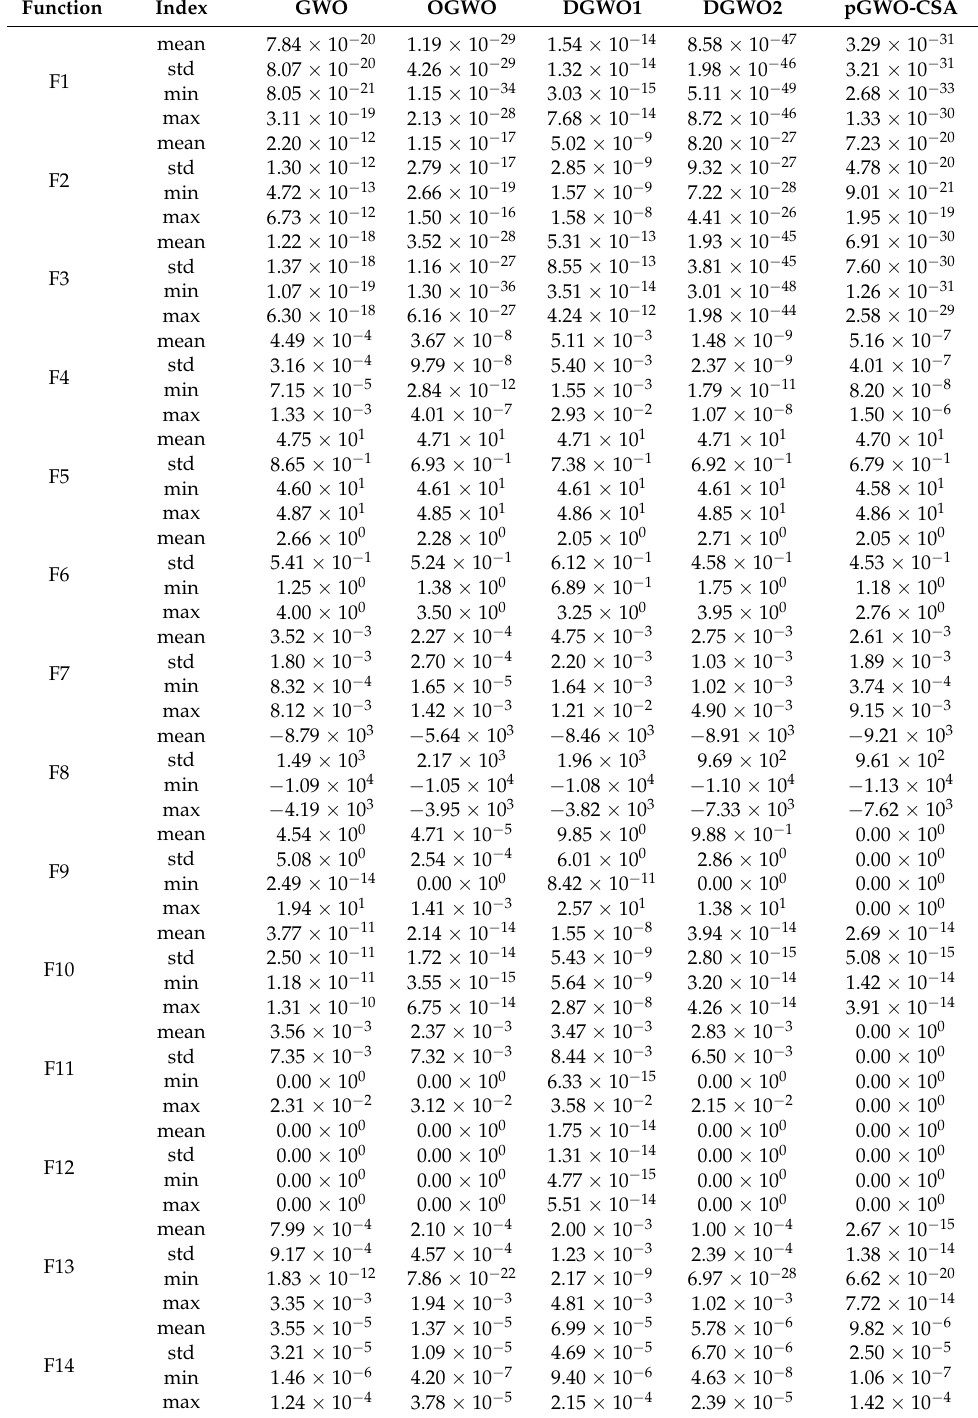
Table 7. The experimental results under 50